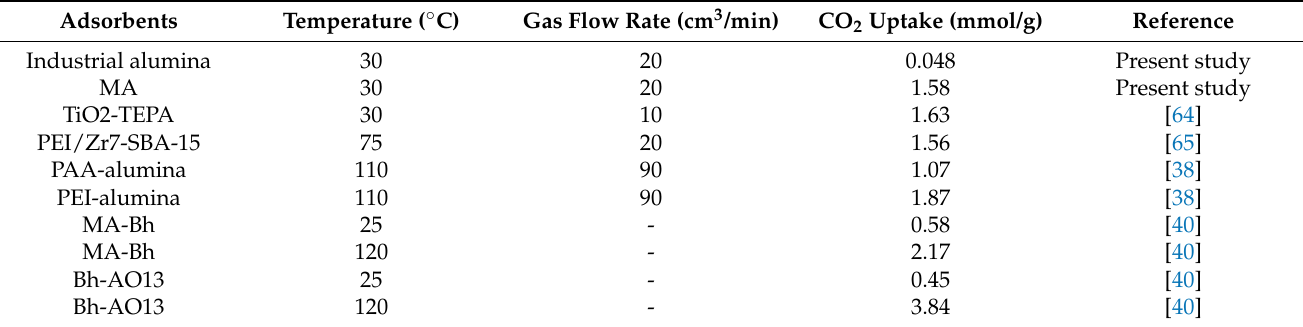
Table 9. CO 2 adsorption performance of various